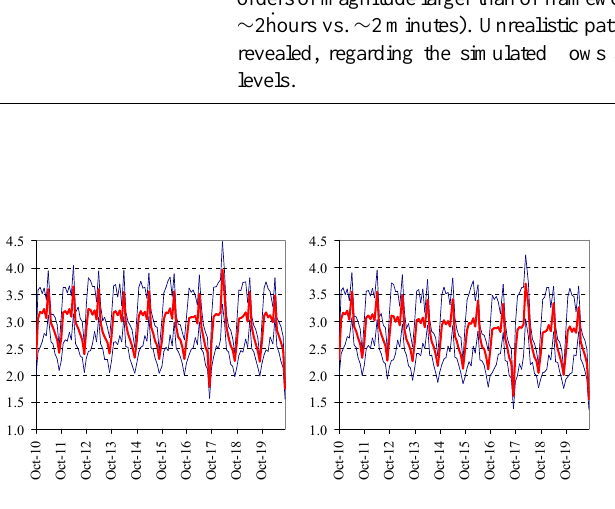
Fig. 10. Simulated discharge (m 3 s − 1 ) at Melas springs (mean Figure 10 and 50% prediction limits) under the actual abstraction policy (left) and the intensive abstraction policy (right) for the water supply of Athens, according to modelling framework